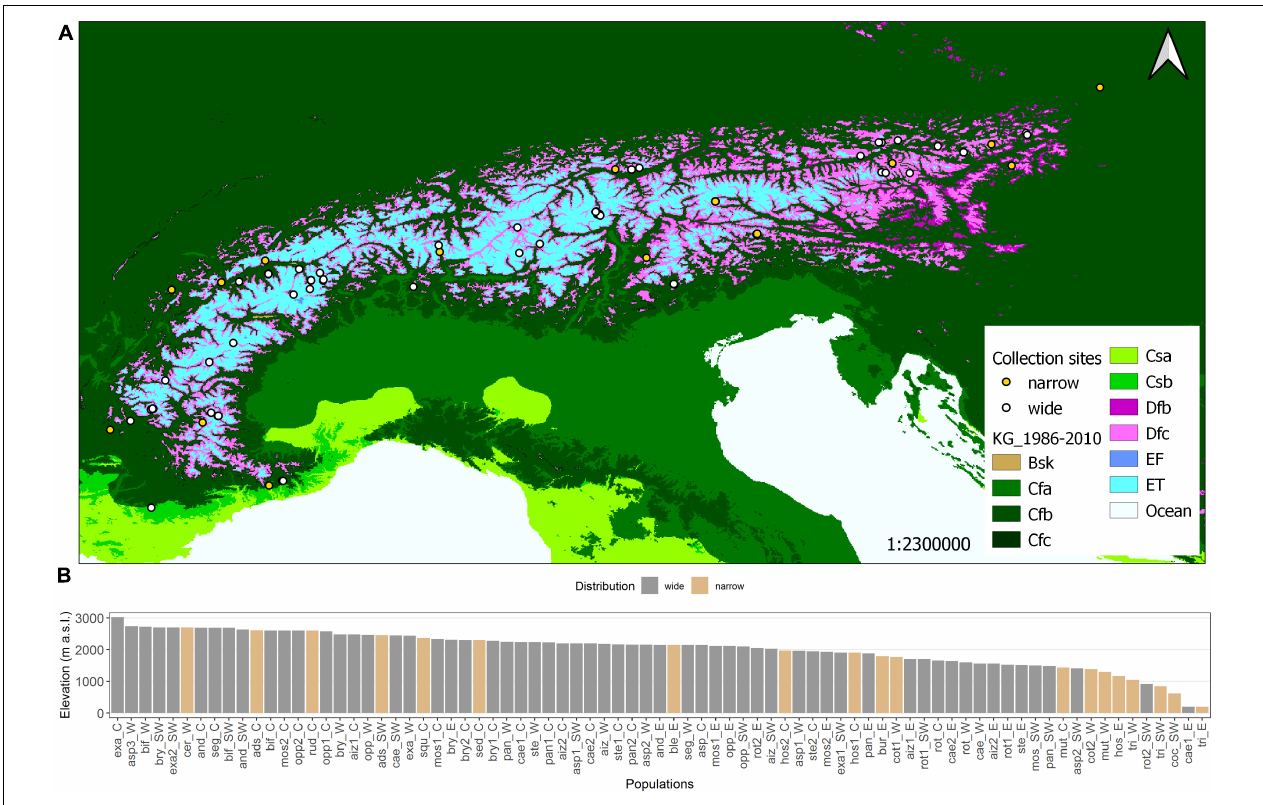
FIGURE 1 | (A) Köppen-Geiger climate map (open source) of the European Alps and seed collection sites (points). In total, 79 populations of Saxifraga spp. were collected from Southwest (France) to the East (Austria). As some points overlap in the overview, detailed location maps are provided in Supplementary Figure 1 . The climatic zones can be classified as arid (Bsk), warm temperate (Cfa, Cfb, Cfc. Csa, Csb), boreal (Dfb, Dfc), and alpine (ET, EF). (B) Histogram of elevations of seed collection sites per population, in descending order of